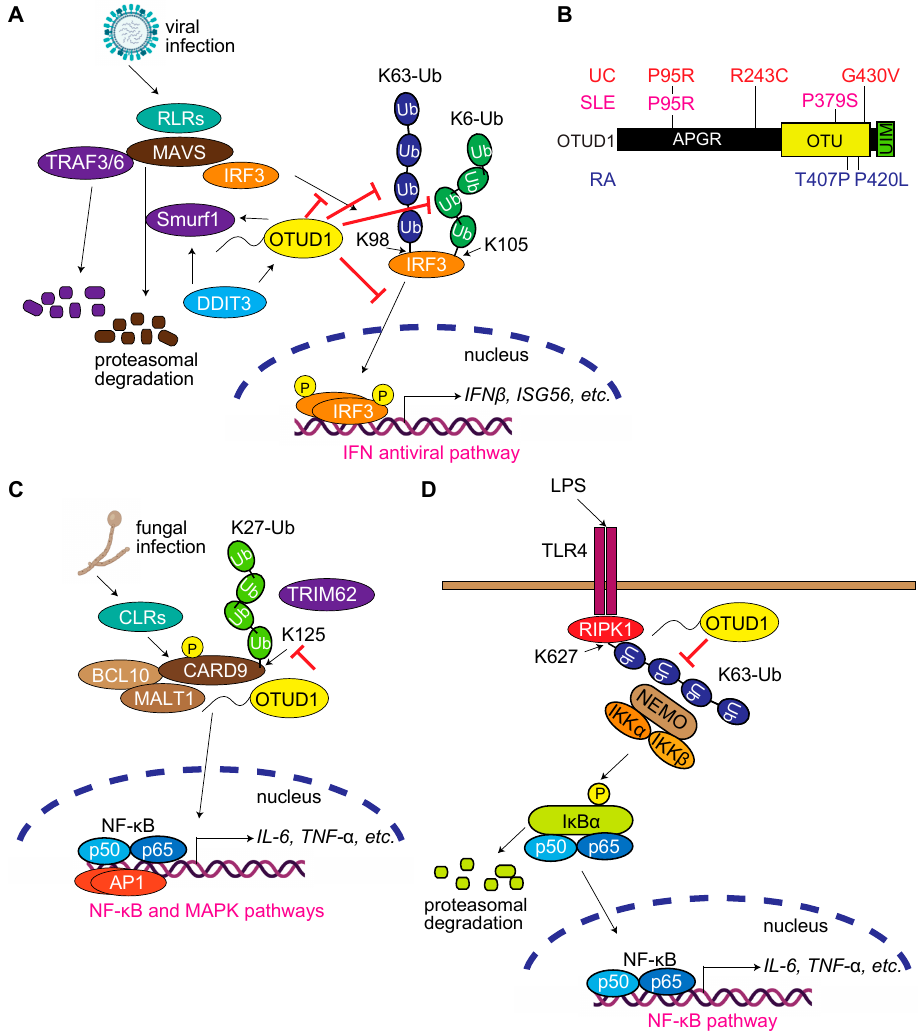
Figure 4. OTUD1 regulates antiviral and innate immune responses, and mutations in OTUD1 are associated with autoimmune diseases. ( A ) OTUD1 regulates the IRF3-mediated type I IFN production pathway as an antiviral response [37–39]. ( B ) Mutations in OTUD1 are associated with autoimmune diseases [41]. The amino acid mutations in OTUD1 and associated autoimmune diseases are shown. UC, ulcerative colitis; SLE, systemic lupus erythematosus; RA, rheumatoid arthritis. ( C ) OTUD1 regulates CARD9-mediated NF- κ B and MAPK signaling pathways upon fungal infection [43,44]. ( D ) OTUD1 cleaves the K63-linked ubiquitin chain on RIPK1 and regulates the NF- κ B pathway [45].